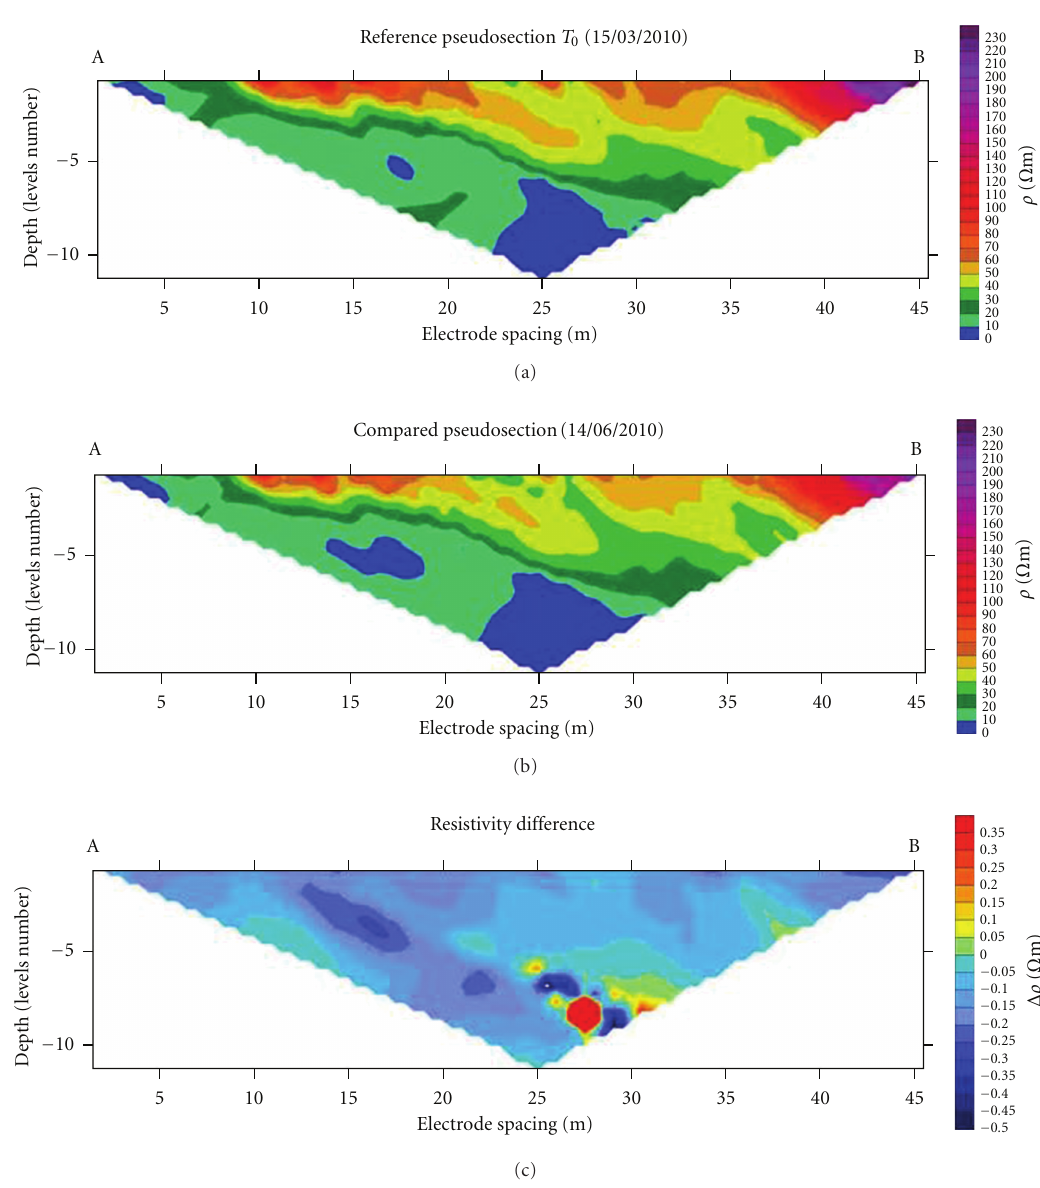
Figure 12: Resistivity di ff erences calculated with respect to a fixed time T 0 (15/03/2010). No important resistivity variations are observed.